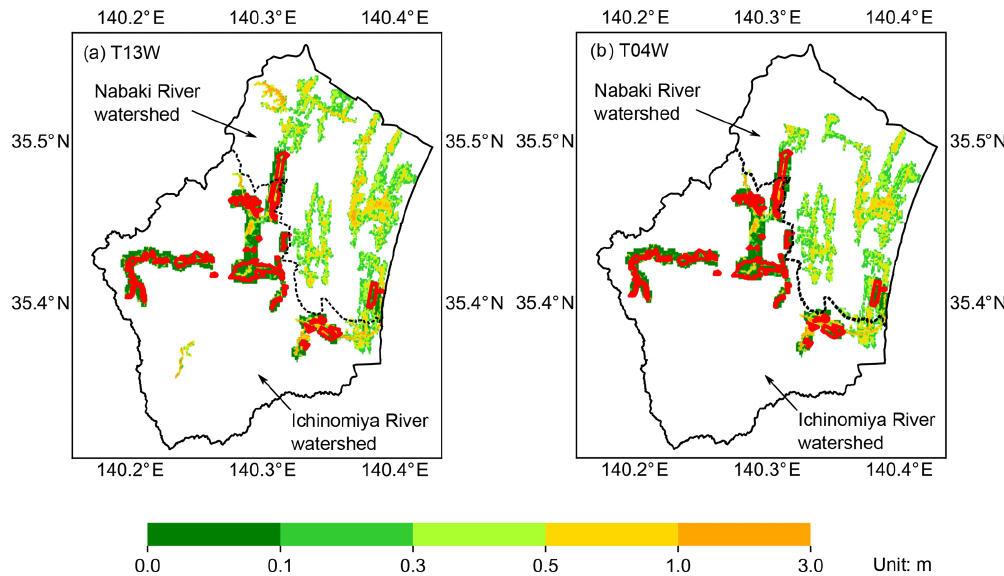
Figure 4. Inundation areas of observation and simulation in both Nabaki and Ichinomiya River watershed. The boundary of the watershed is based on Dutta et al. (2006). The regions surrounded by red lines are the reported inundation areas by Chiba Prefecture (2013) mainly in Ichinomiya River watershed.